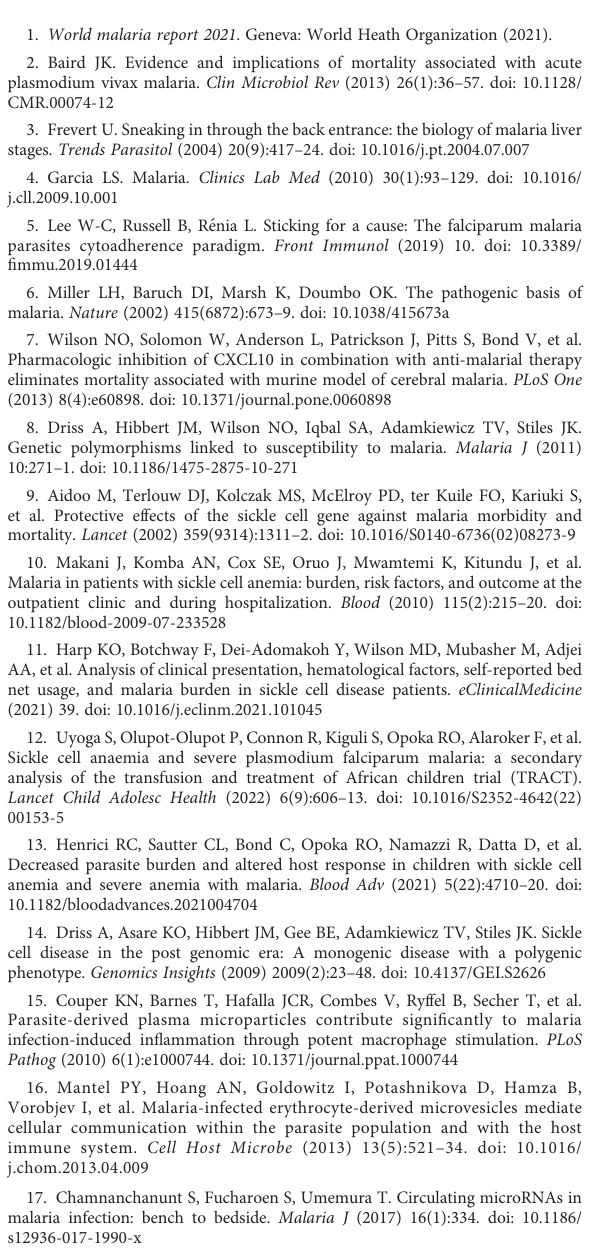
SUPPLEMENTARY FIGURE 5 (A – P) Quantitative analysis of cytokine concentration Bio-Plex Pro Human Cytokine Group I Panel (Bio-Rad cat # M500KCAF0Y). Y axis indicates concentration in pg/mL. One-way ANOVA and Tukey ’ s multiple comparison test performed. (*= P<0.05,